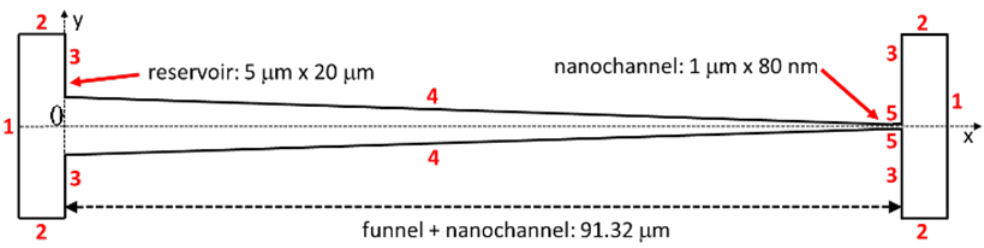
Figure 1. Sketch of the system geometry used for the FEM calculations. The red numbers correspond to walls with the same boundary conditions.